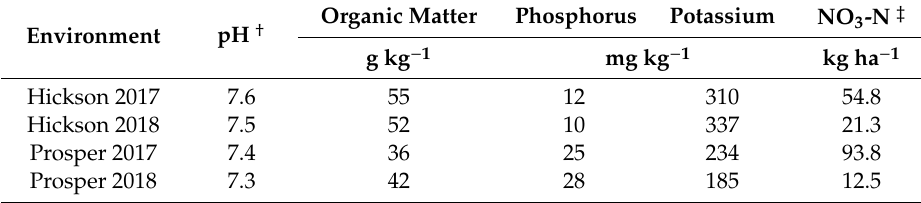
Table 3. Soil sample results taken after wheat harvest and before cover crop sowing at each